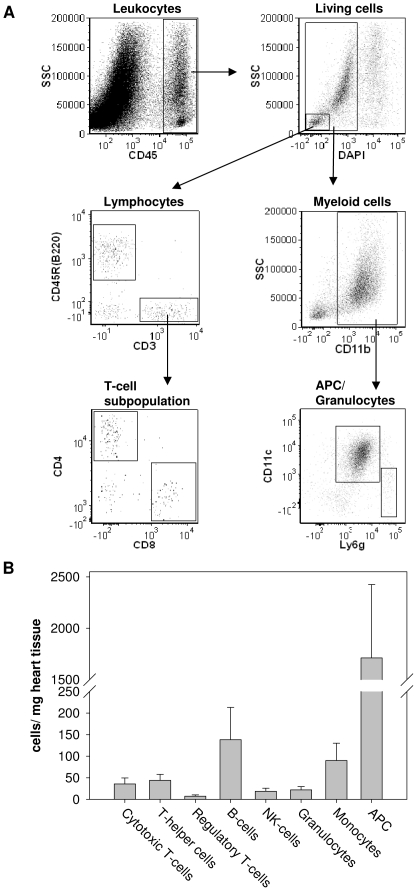
Leukocyte subpopulations in myocardial tissue under basal conditions.
A: Gating strategy used to identify different leukocyte subpopulations by multiparametric flow cytometry. CD45+ cells were gated and DAPI-staining was used to exclude dead and apoptotic immune cells. Living CD45+ cells were then divided in subleukocyte populations using a panel of cell-specific fluorochrome-labeld antibodies. Lymphocytes were gated into CD45R(B220)+ cells (B-cells) and CD3+ cells (T-cells). T-cells were subdivided in CD4+ cells (T-helper cells) and CD8+ cells (cytotoxic T-cells). Myeloid cells were characterized as CD11b+ cells and further subdivided in CD11c+ cells (APCs) and Ly6g+ cells (granulocytes). B: Leukocyte subpopulations in the unstressed heart. Values are means ± SD of n = 5 experiments.